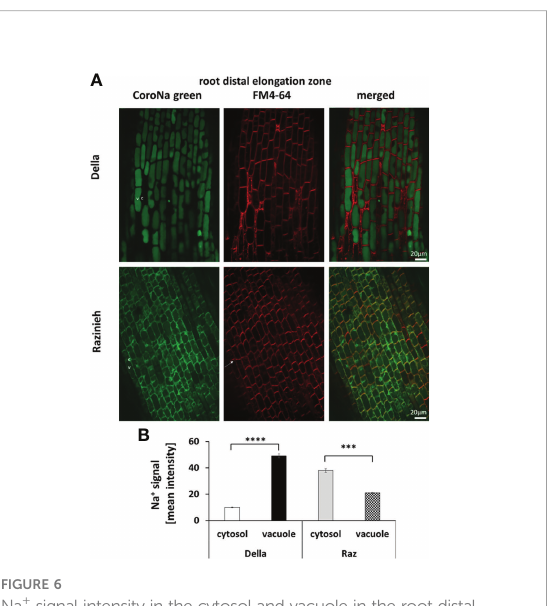
FIGURE 5 Na + signal intensity in the root meristem zone of 4-day-old sorghum seedlings grown in darkness treated with 100 mM NaCl for 24 h (A) Representative images of root meristem zone cells of Della and Razinieh genotypes stained with CoroNa Green dye, and FM4- 64 dye (B) Averaged values for Na + signal intensity in the cytosol and vacuole in the root meristem zone. Mean ± SE [ n = 77 (Della) and 57 (Razinieh)]. Asterisks indicate a statistically signi fi cant difference between treatment and corresponding control, as determined by Student ’ s t -test (**** P < 0.0001).